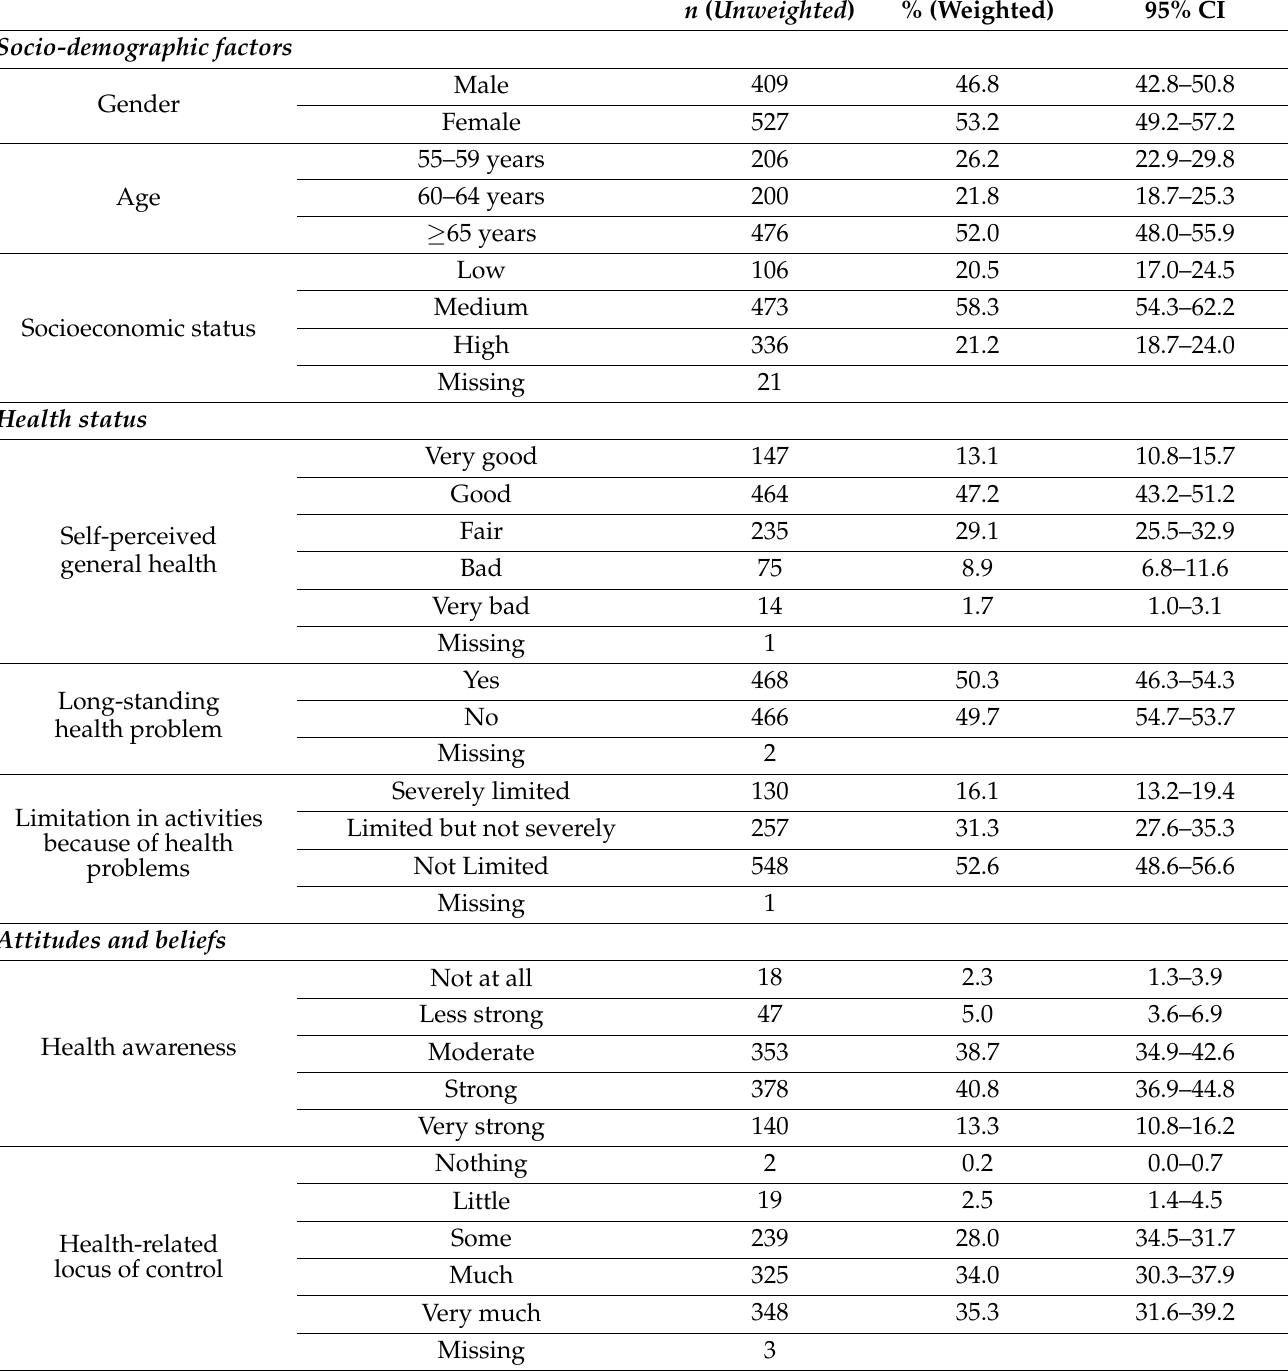
Table 1. Characteristics of the study population aged 55 years or